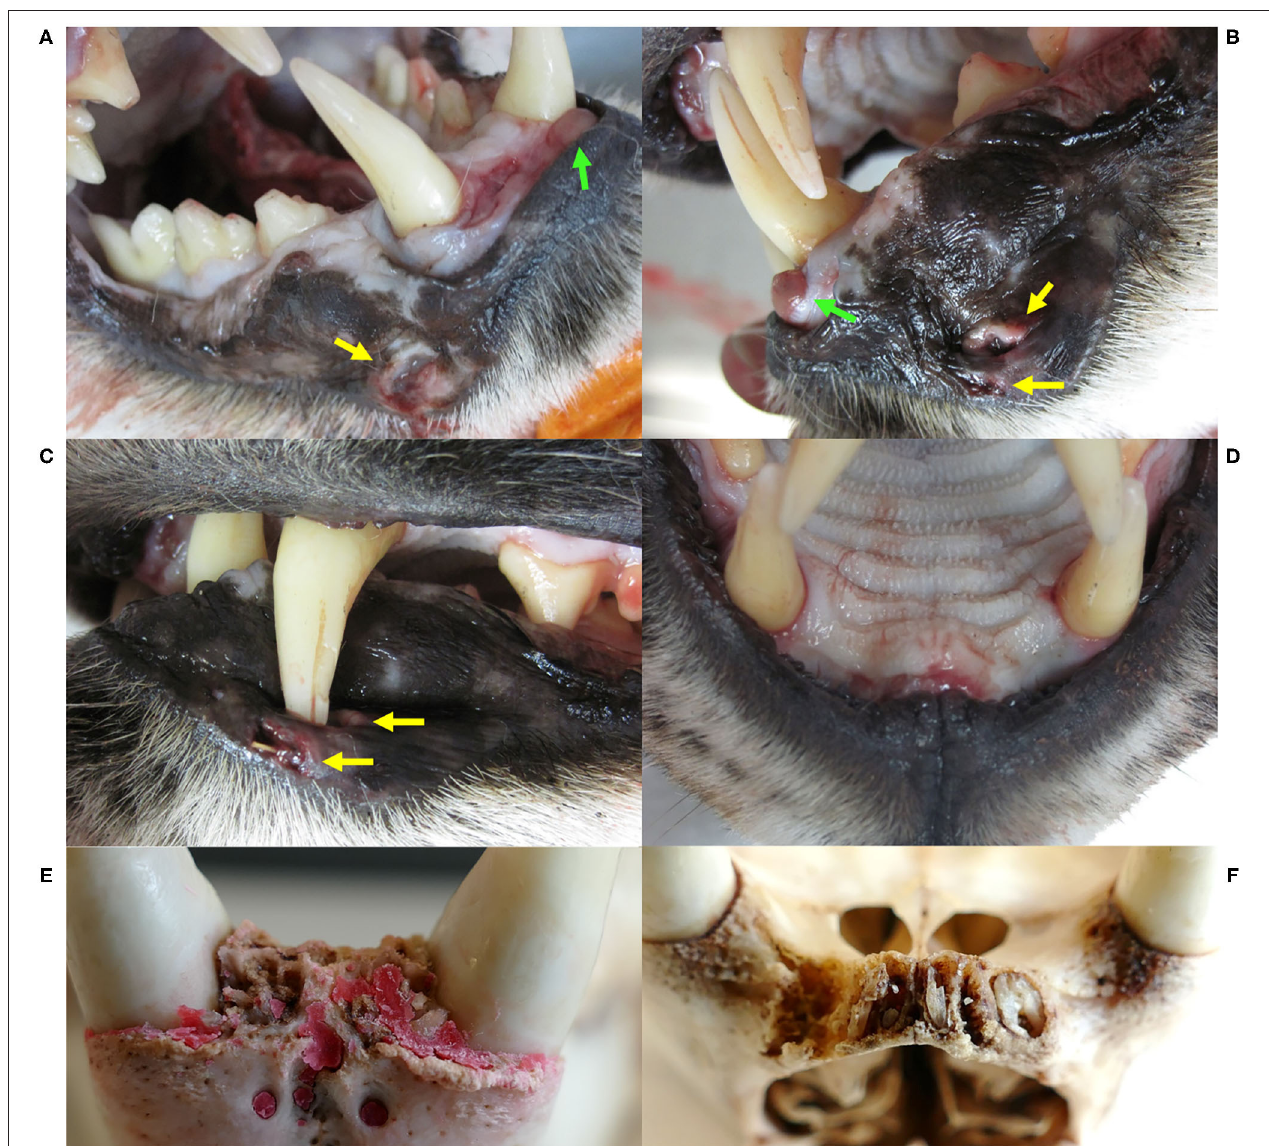
FIGURE 8 | Dental and gingival lesions, Eurasian lynx (Lynx lynx ), ADIN; (A) Right fronto-lateral view and (B) left lateral view of the opened mouth, necropsy: bilateral wound (yellow arrows) possibly caused by puncture of the maxillar canines, a tumorous tissue formation (green arrows), tooth abrasions of the right premolars and first mandibular molar, and enamel defects of the maxillar left canine. (C) Left lateral view of the closed mouth, necropsy, with closed mouth, showing lip perforation by the upper left canine aside from an open wound with intralesional foreign body. (D) Fronto-ventral view of the maxilla, necropsy: all incisors missing with focal gingivitis. (E) and (F) Ventral views of the frontal part of the mandibula and maxilla, respectively, prepared skull: all incisor crowns missing with and chronic osteomyelitis and root remnants in the maxillar alveoli. Red deposits on picture E are artifacts.